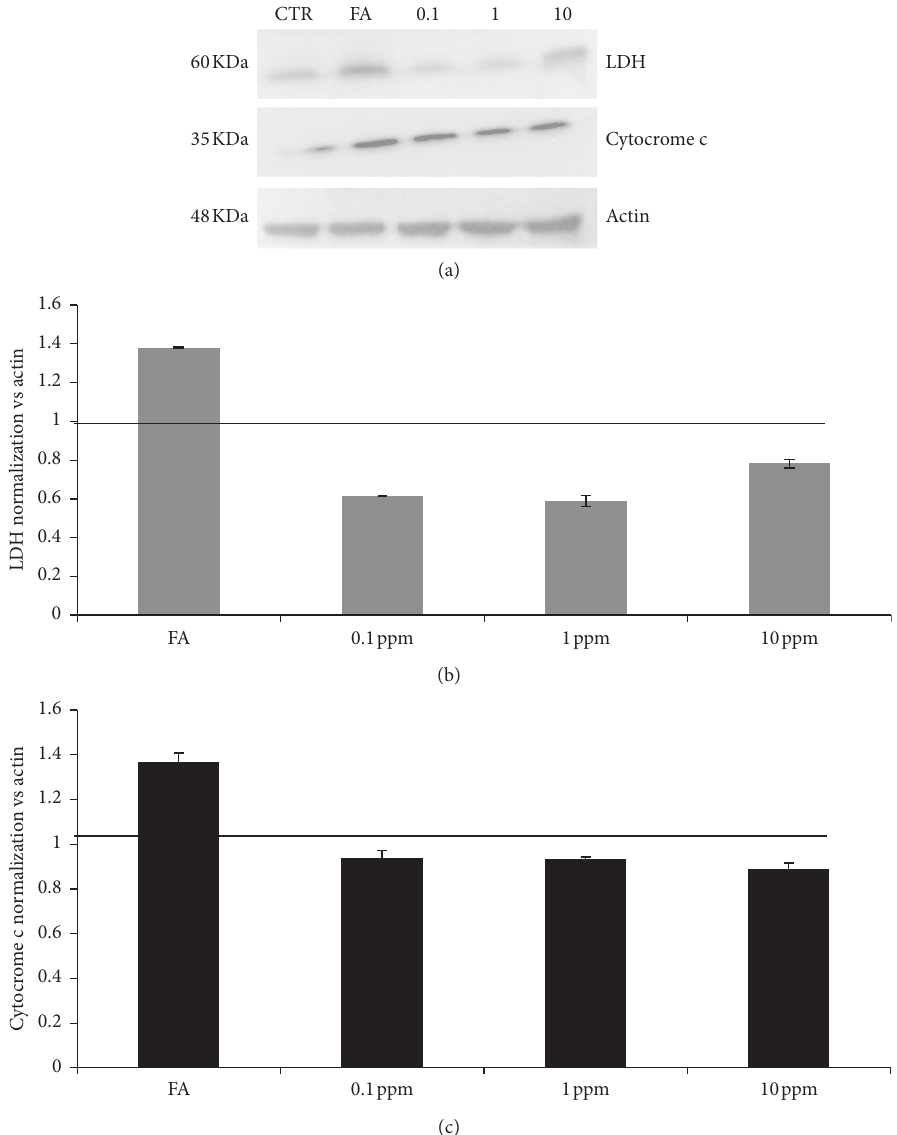
Figure 3: Western blot for LDH and cytochrome c. Densitometry plot (a) showing an inverse dose-dependent reduction of LDH levels in pethoxamid-treated cells. Densitometry plot (b, c) demonstrating LDH and cytochrome c reduction. Actin was used to normalize the results. Values are means ± SD from three separate